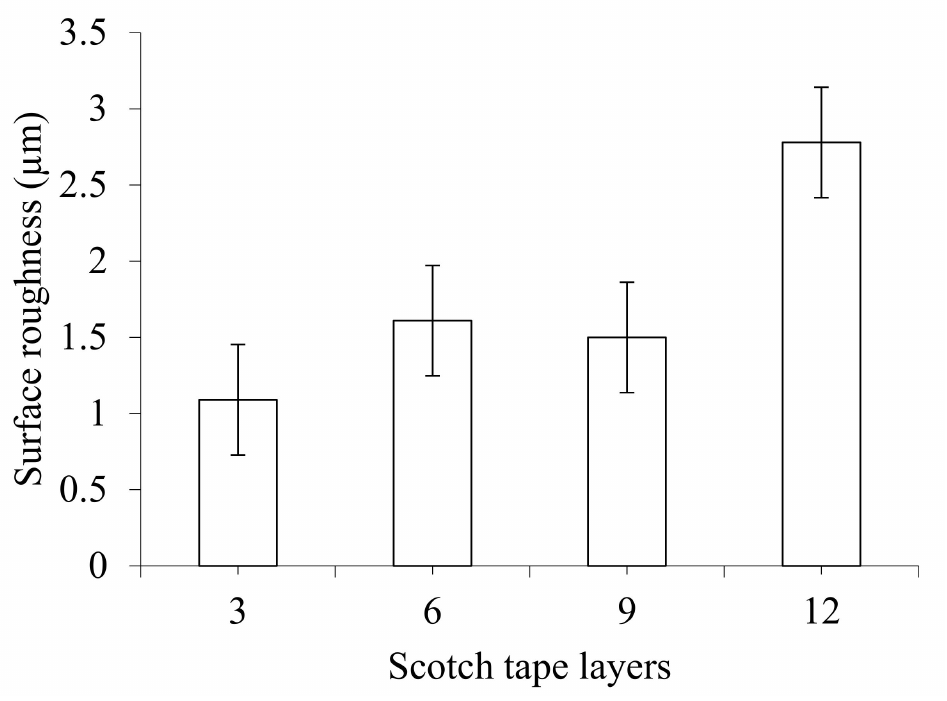
Figure 5. Effect of Scotch tape layer on surface roughness at drill bit diameter of 6 mm, point angle of 125 ◦ , spindle speed of 2250 rpm, and feed rate of 0.11